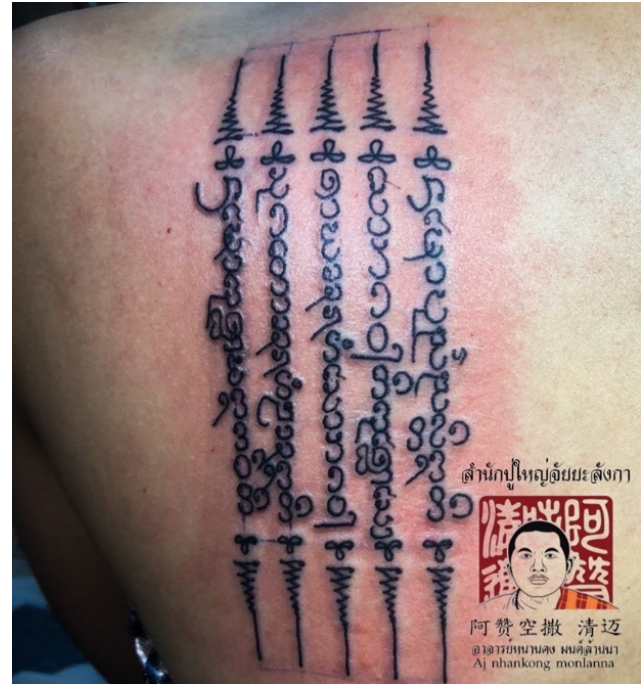
Figure 2. Five-line sak yantra. Photo by Aj Nhankong Monlanna.